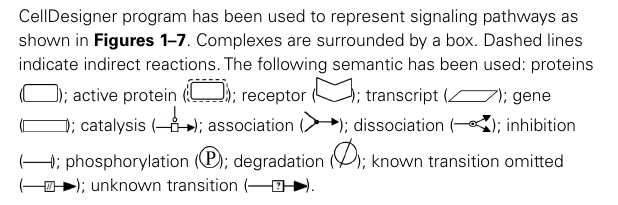
CellDesigner program has been used to represent signaling pathways as shown in Figures 1–7 . Complexes are surrounded by a box. Dashed lines indicate indirect reactions.The following semantic has been used: